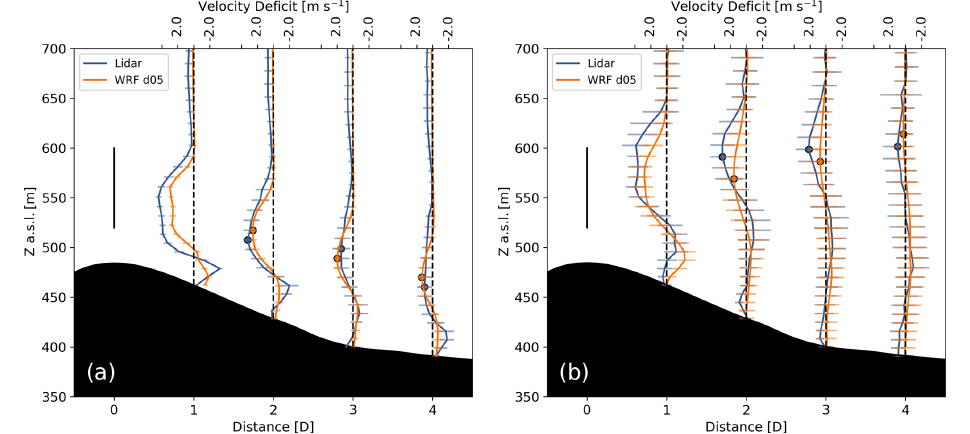
Figure 14. One-hour time-averaged profiles of velocity deficit along the wake transect based on the lidar measurements and calculated in WRF–LES–GAD d05 for the (a) stable and (b) convective case studies. The error bars correspond to ± σ , where σ is the standard deviation during the averaging period. The solid black line represents the diameter of the wind turbine rotor.